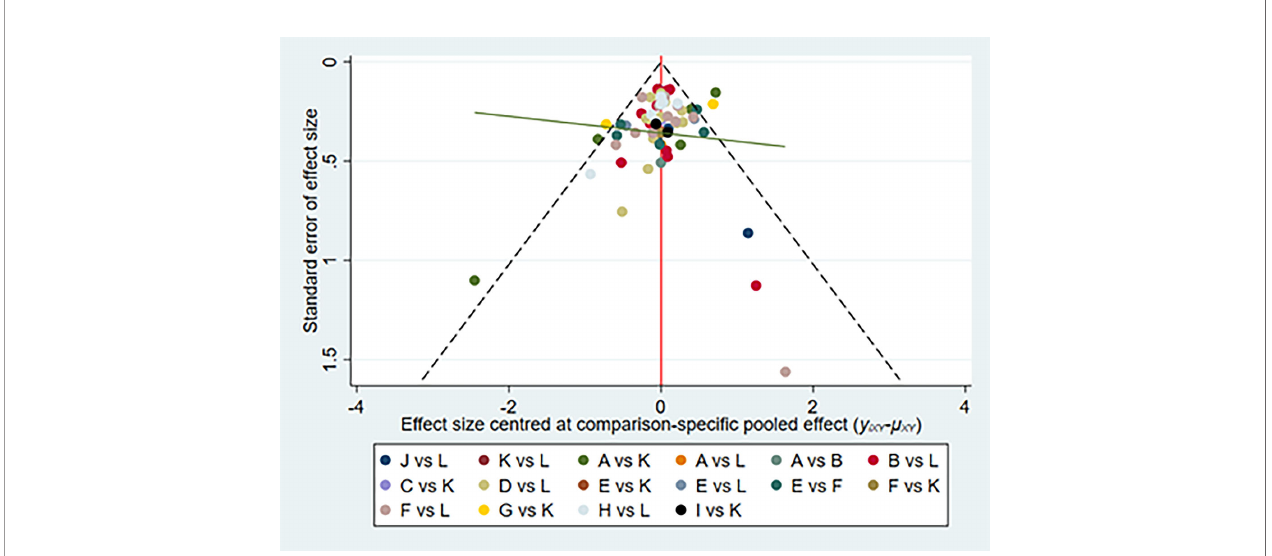
FIGURE 4 | Network of funnel plot for adverse events. A, adalimumab; B, adalimumab + DMARD; C, certolizumab; D, certolizumab + DMARD; F, etanercept; G, etanercept + DMARD; H, golimumab; I, golimumab + DMARD; J, in fl iximab; K, in fl iximab + DMARD; L, DMARD; DMARD, disease-modifying anti-rheumatic